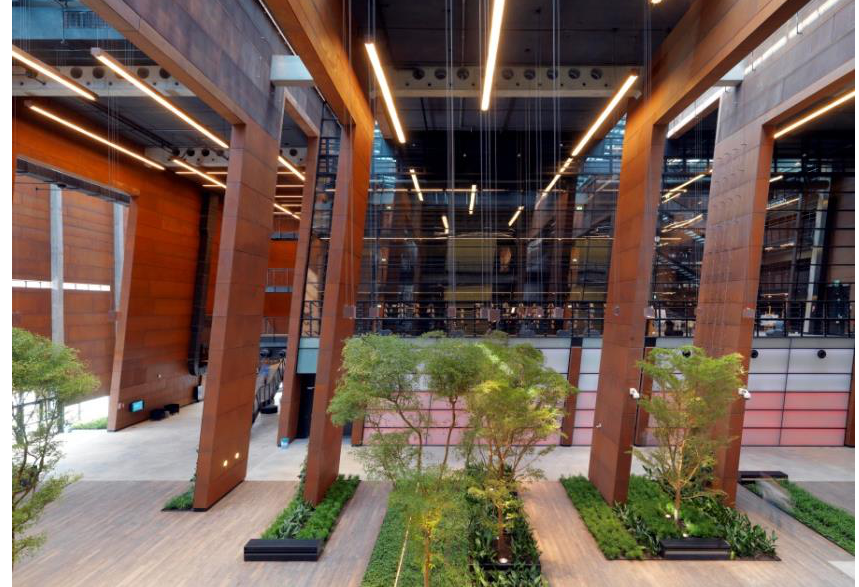
Figure 7. The ECS, winter garden (photo by Wojciech Kryński) .